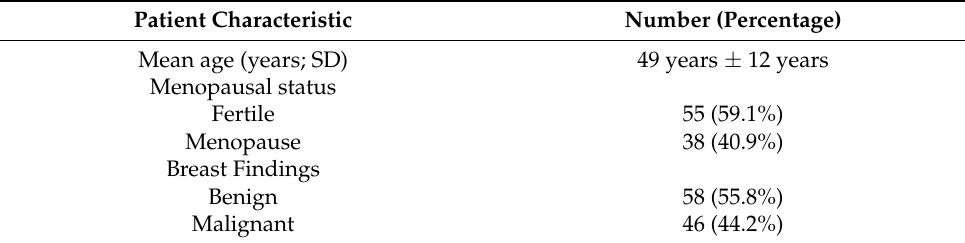
Table 1. Characteristics of the 93 patients included in the analysis.